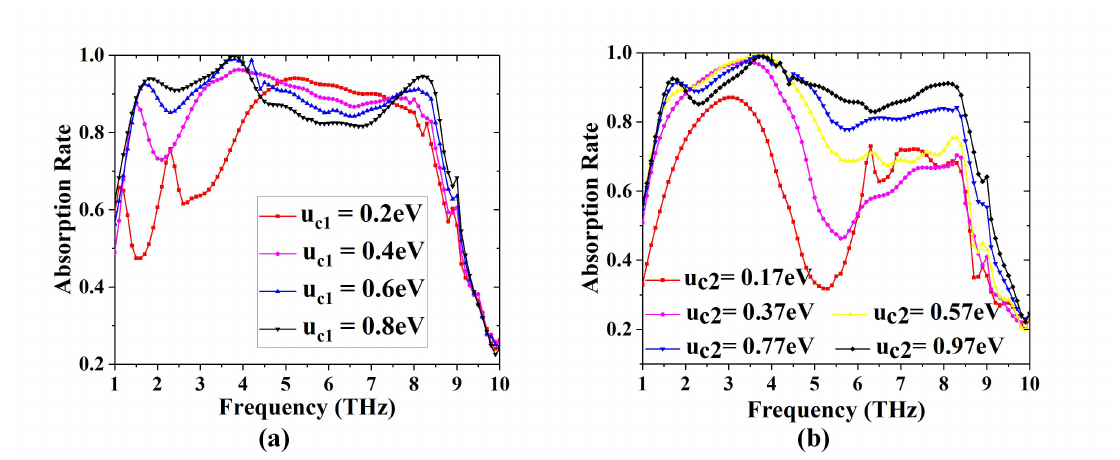
Figure 9. The simulated absorption spectrum with changing graphene loading voltage of ( a ) the first graphene layer, ( b ) the second graphene